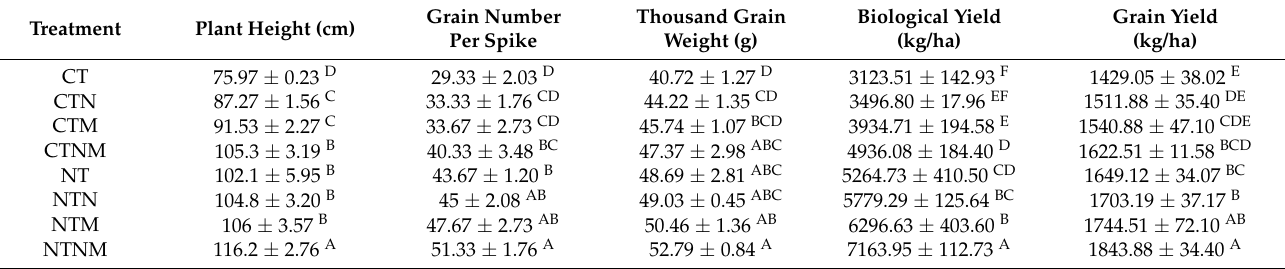
Table 6. Effects of tillage and nitrogen fertilization on yield of spring wheat.